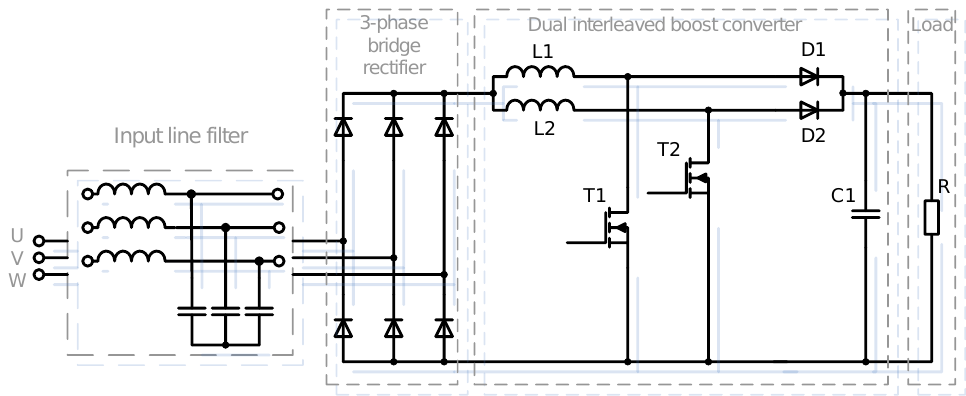
Table 3. Parameters of PFC converter used for experiments.